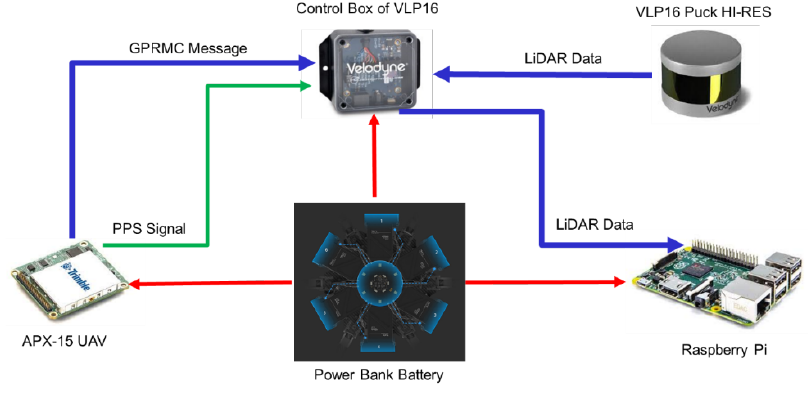
Figure 2. Integration scheme for the M600 UAV-based system.